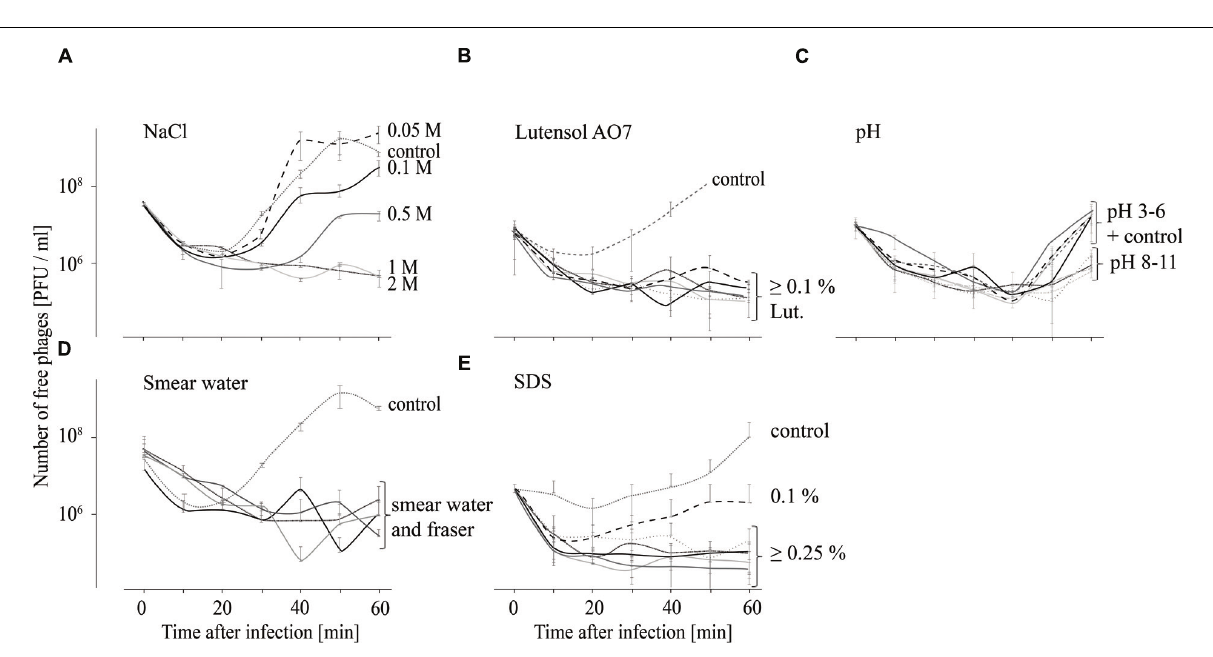
FIGURE 2 | Adsorption tests performed over 60 min indicating attachment (decreasing number of free phages) of phage P100 to L. monocytogenes in TSB containing NaCl (A), Lutensol AO 7 (B), TSB adjusted to pH values 3–11 (C), smear water and Fraser (D), and TSB containing SDS (E). All experiments were done twice and in duplicates and mean values and standard deviations were